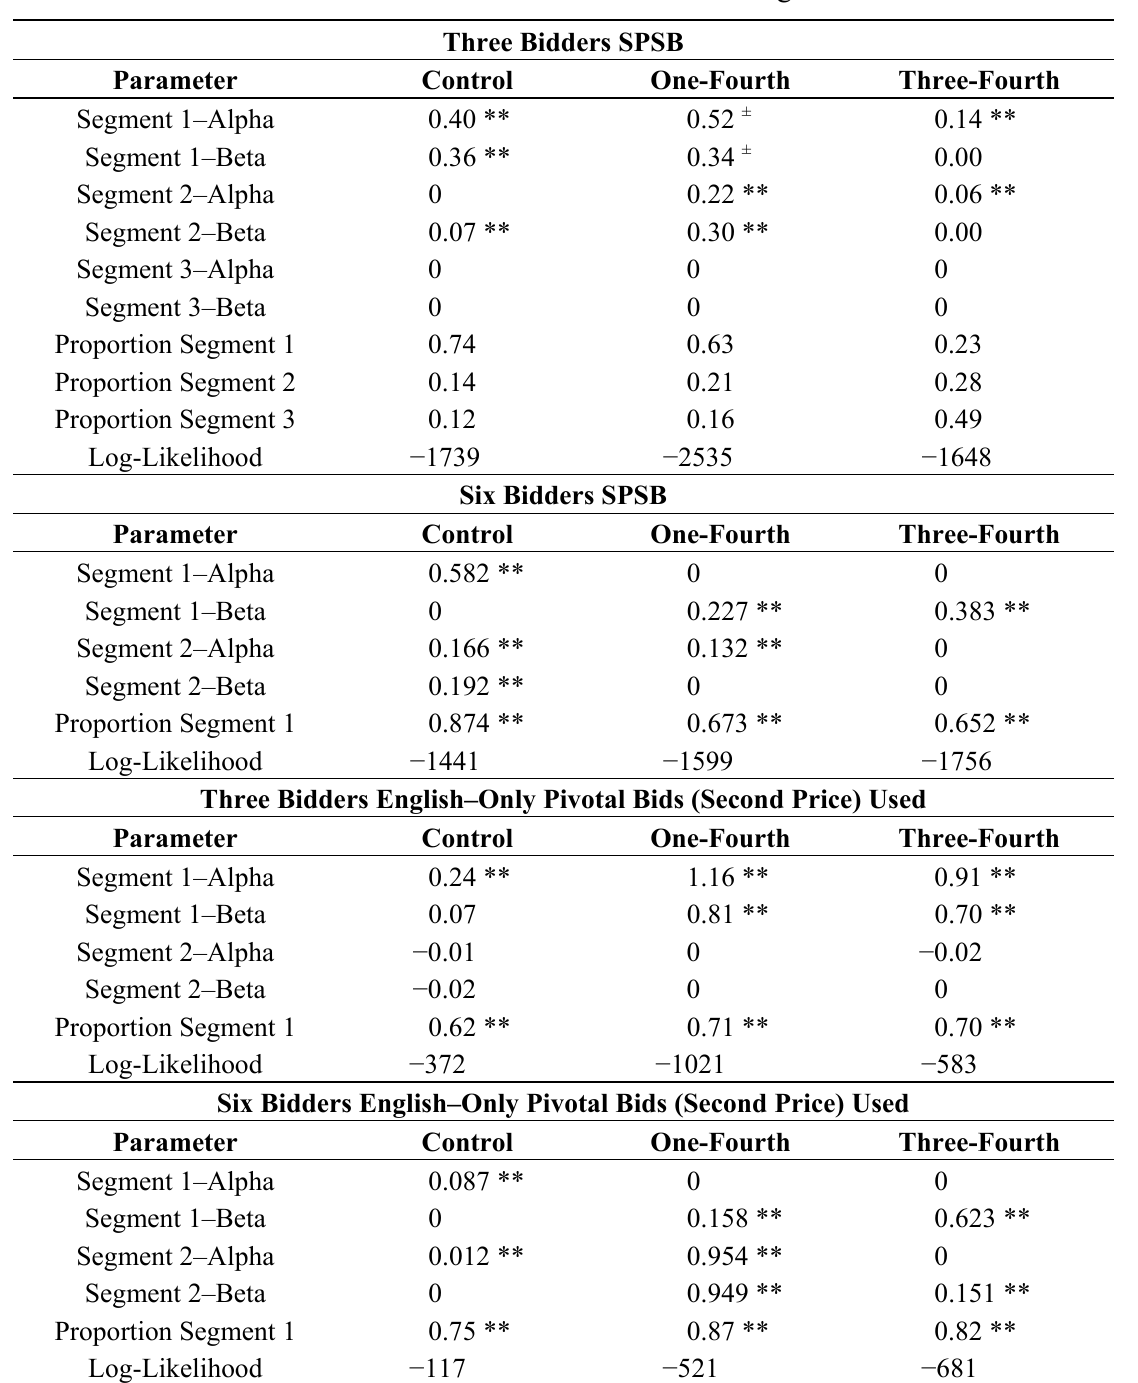
Table 5. Mixture model estimates of the bidding